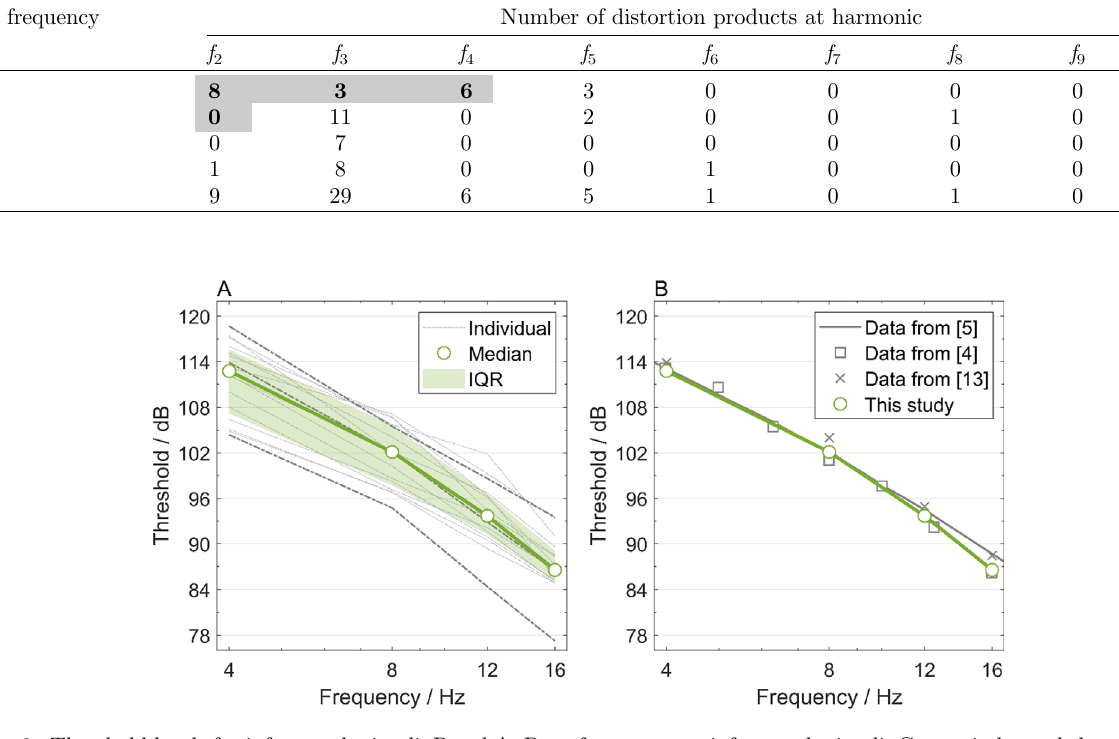
Figure 6. Threshold levels for infrasound stimuli. Panel A: Data for pure-tone infrasound stimuli. Green circles and the green semi- transparent area show the median sound pressure level at threshold in dB and the corresponding interquartile range, respectively, across all 16 listeners. Gray dotted-dashed lines indicate individual thresholds; the slightly darker and thicker lines indicate thresholds of those three listeners, who had most ear-generated distortion products (see text). Panel B: The green circles are a reproduction of the median thresholds in Panel A. The gray solid line indicates the 2nd-order regression of reference thresholds reported in Figure 10 of [5]. The boxes represent threshold values reported in [4]. Crosses indicate pure-tone thresholds published in [13]; fi ve out of their 14 listeners also participated in the present study.